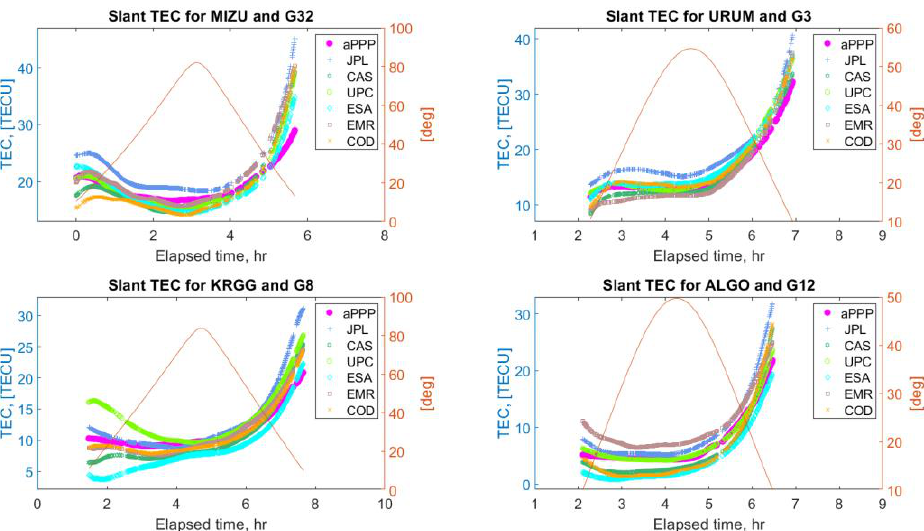
Figure 13. Comparison of the STEC values retrieved using the ionosphere retrieval equation (labeled as aPPP) and GIM STEC values from six different Ionosphere Associate Analysis Centers (IAAC) for IGS stations MIZU, URUM, KRGG, ALGO, and GPS satellites G32, G3, G8, and G12. Elevation angles of the corresponding satellites are also plotted.